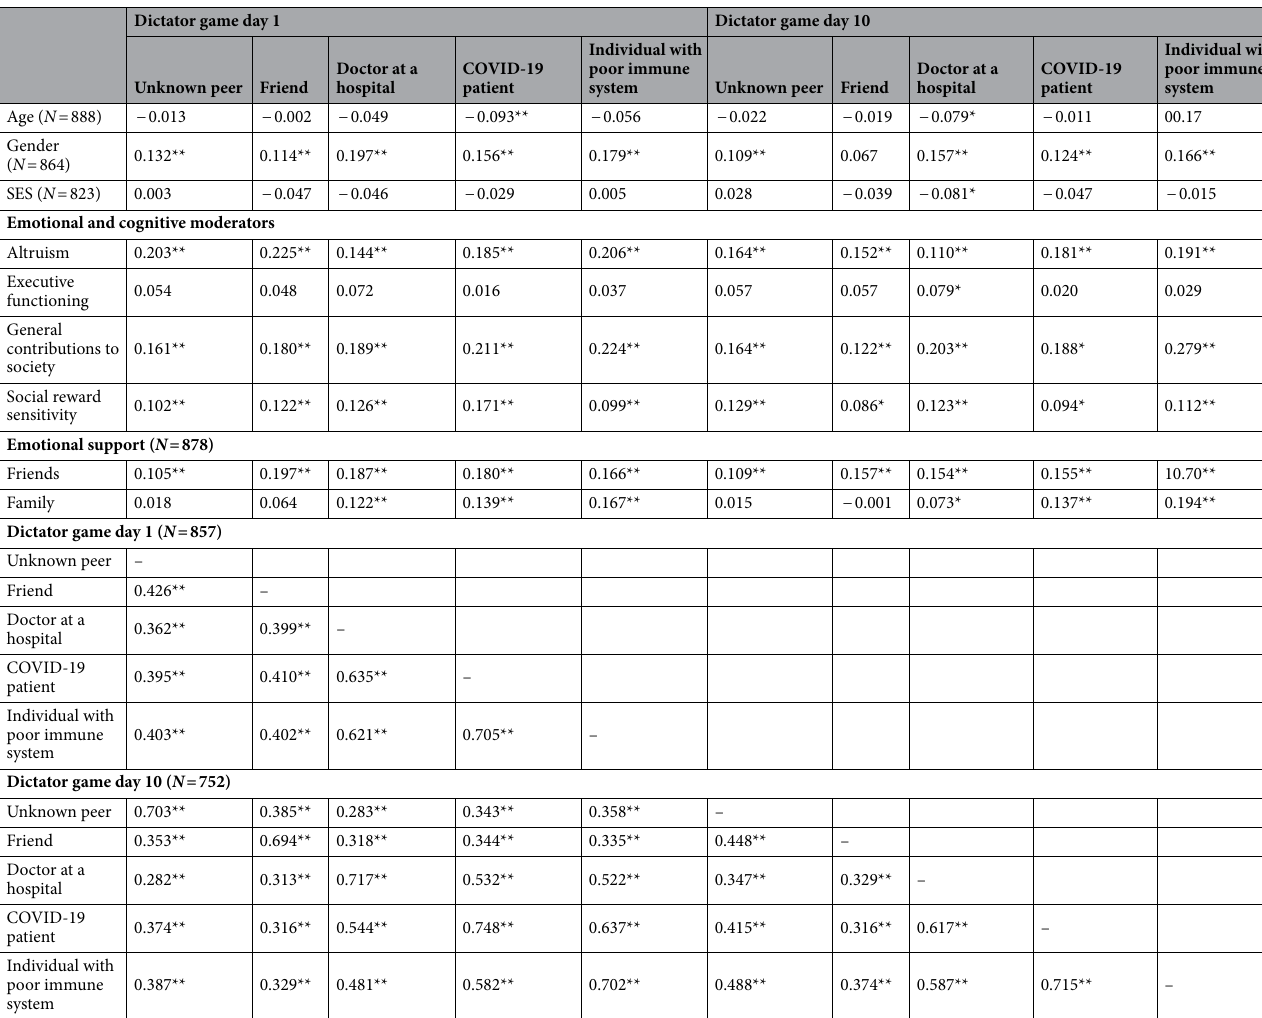
Table 2. Bivariate correlations among all variables used in the statistical analyses (at T1). * p < 0.05, ** p <